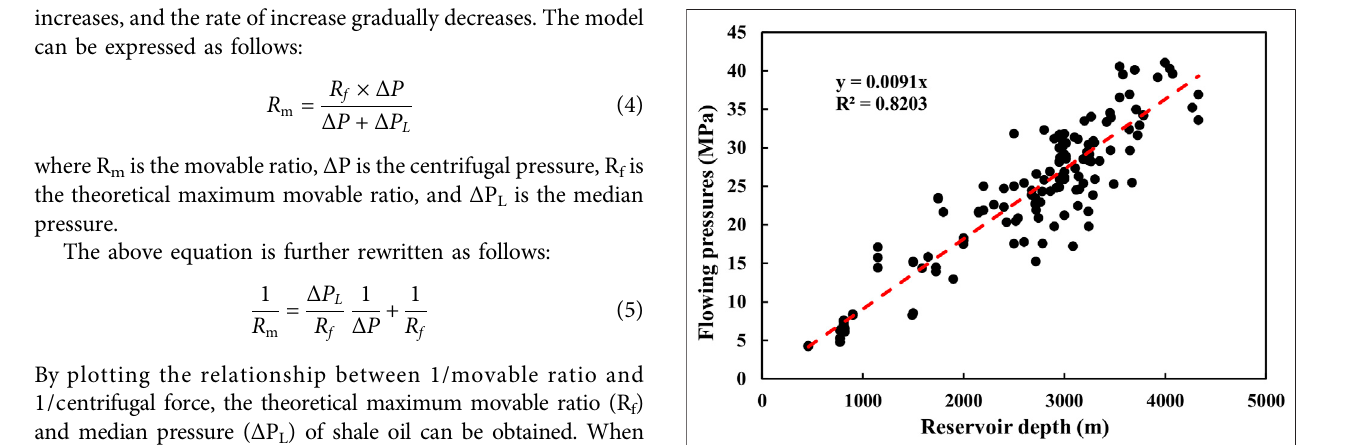
FIGURE 8 | Variation in fl owing bottom hole pressure with